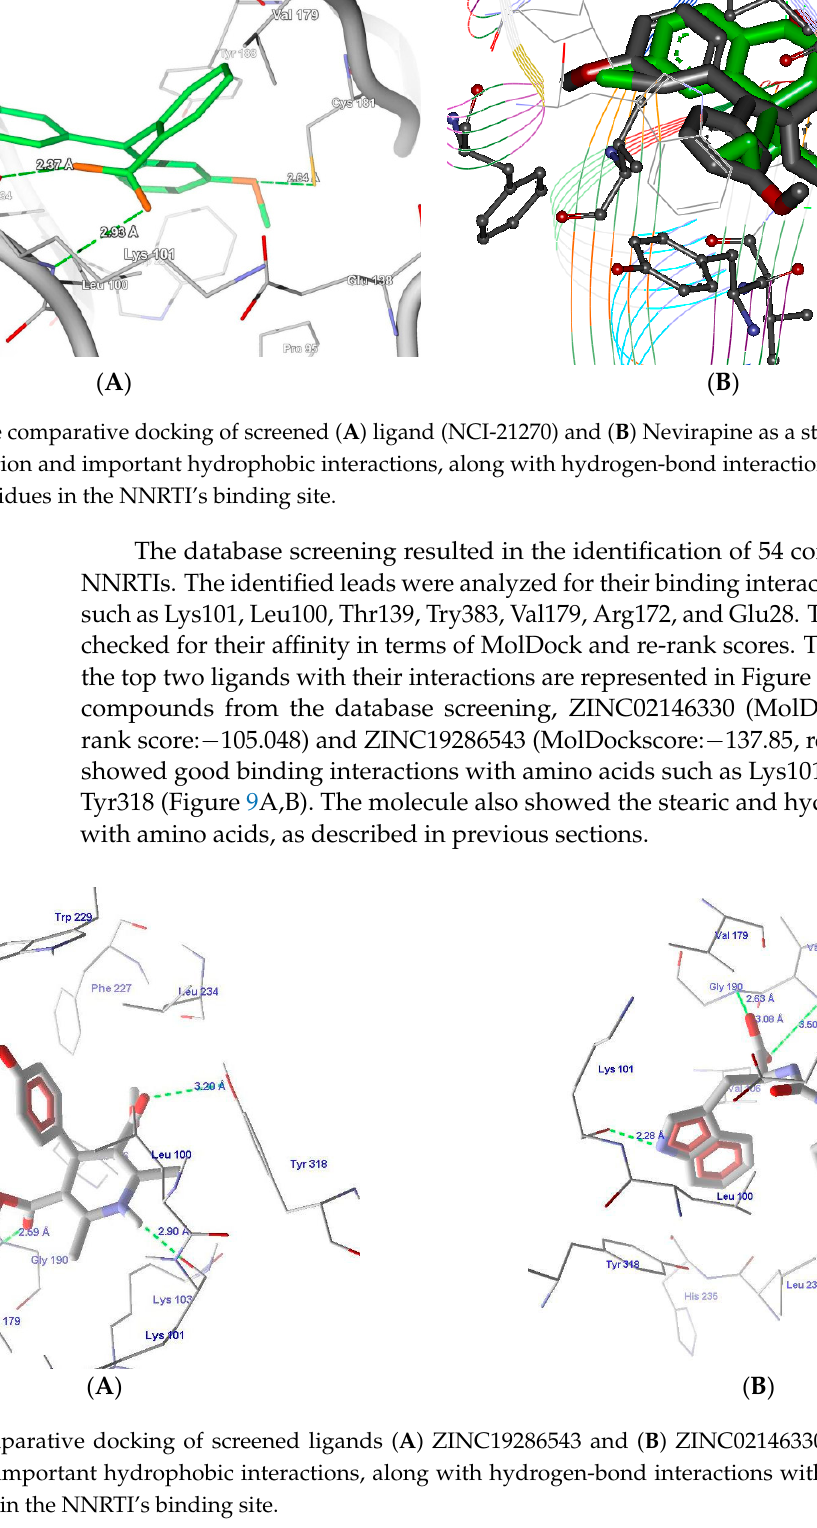
Table 4. The binding scores of identified leads from PBVS.